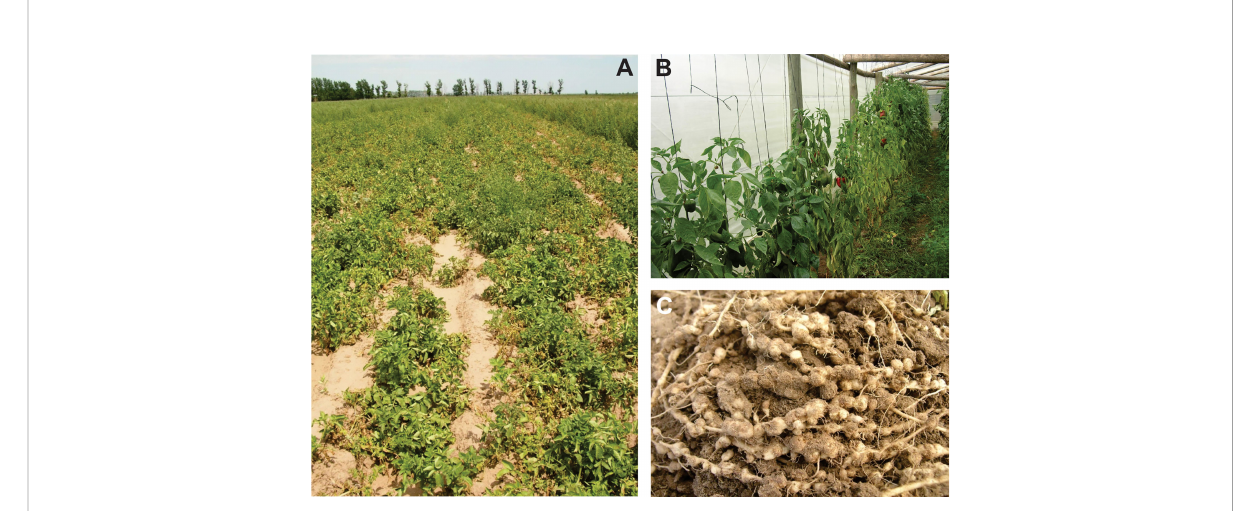
FIGURE 2 Symptoms caused by Nacobbus spp. (A) Potato crop with patches due to the presence of Nacobbus sp.; (B) Pepper crop under greenhouse conditions, showing plants with poor development and wilting due to N. celatus attack; (C) Chard roots with numerous galls induced by N. celatus